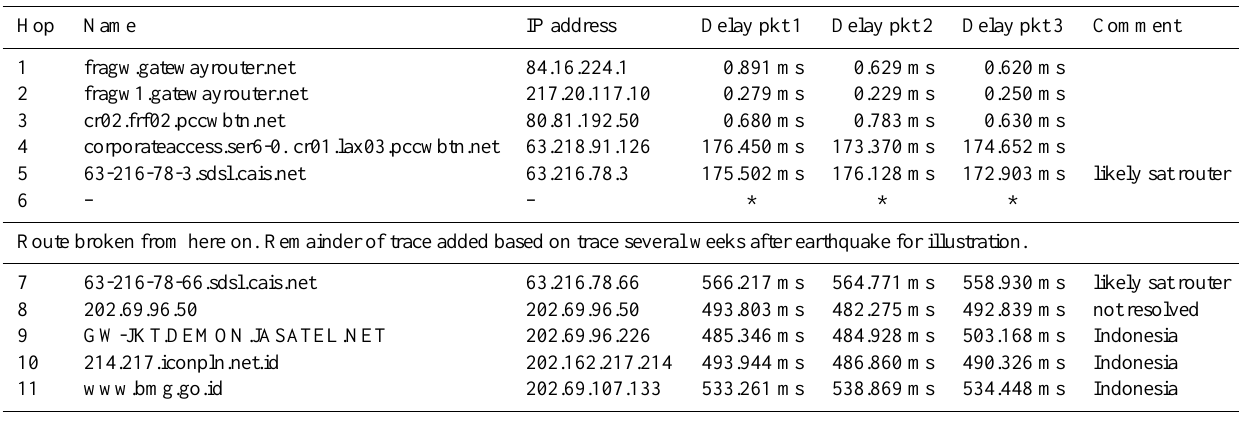
baseband equipment is included, total path delay is closer to 320 milliseconds. Table 3. Traced route originating from DE-CIX a commercial Internet Exchange of German ISPs towards host at BMKG’s Jakarta premises in Indonesia on 26 May, approx. 06:30UTC. The trace shows that the route is broken at the hop towards Indonesia, thus rendering Indonesia unreachable from commercial ISP networks. A router in Los Angeles is the last reachable hop in this trace. For illustration purposes the remainder of the route is added and marked red, based on a trace several weeks after the